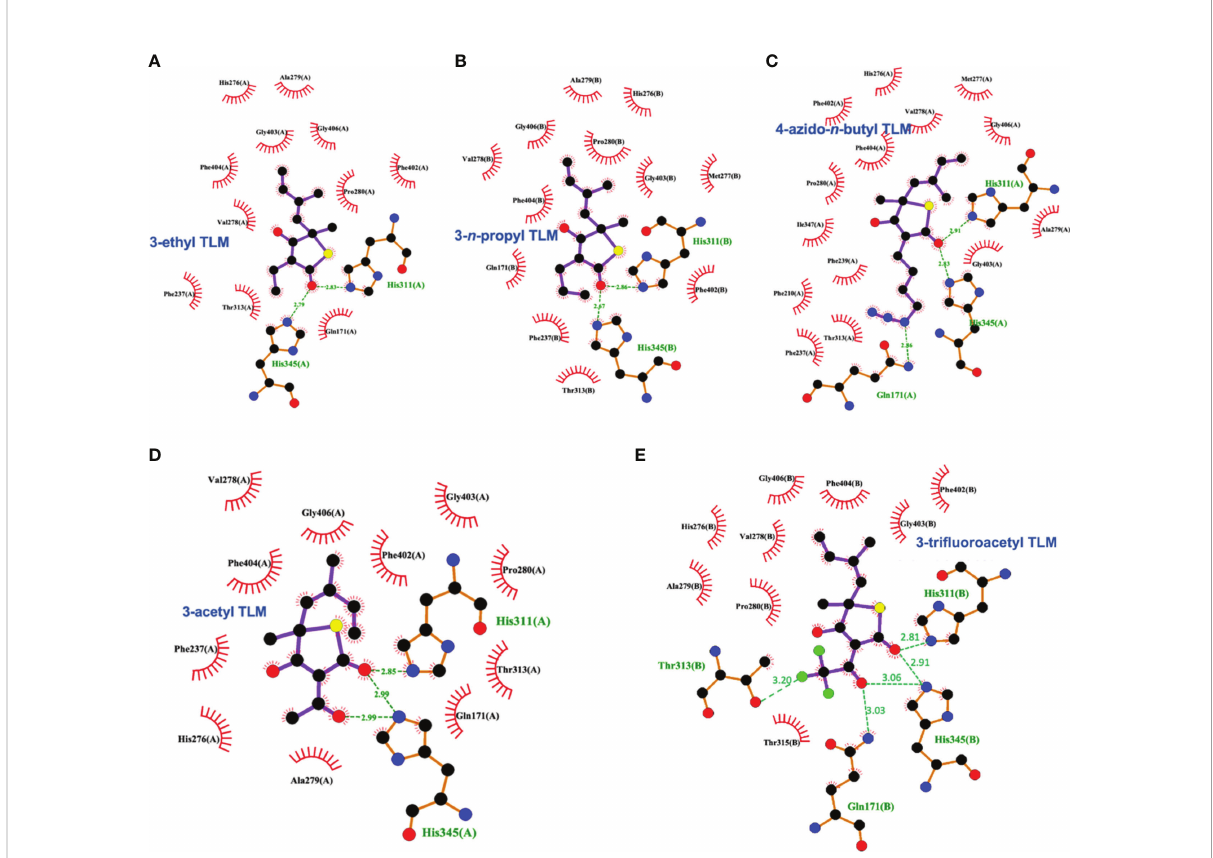
FIGURE 7 Interaction pro fi les for KasA C171Q bound to the following TLM analogs: (A) 3-ethyl (PDB ID 4C6Z), (B) 3- n -propyl (PDB ID 4C70), (C) 4-azido- n -butyl (PDB ID 4C71), (D) 3-acetyl (PDB ID 4C72), and (E) 3-tri fl uoroacetyl (PDB ID 4C73). Hydrogen bonds are shown as green dashed lines and distances are measured in